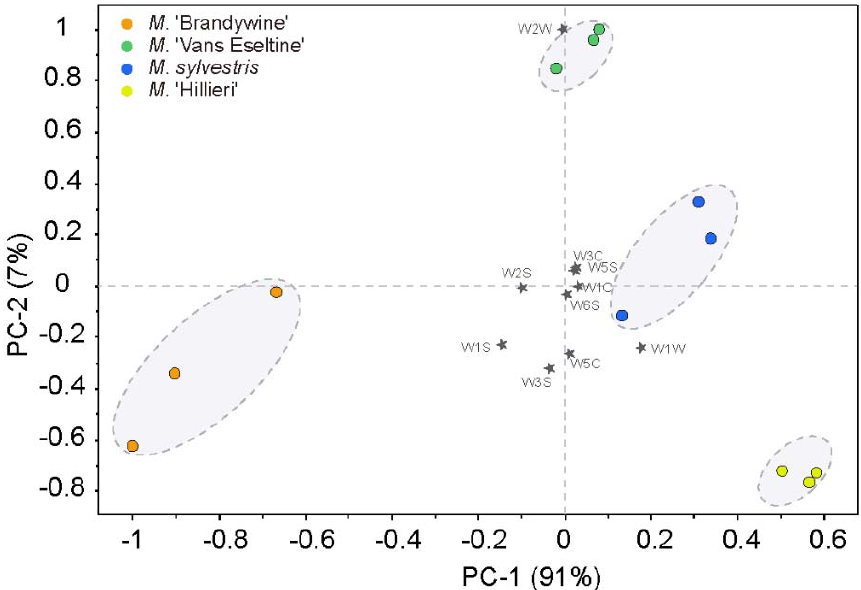
Figure 1. PCA biplot based on the E-nose data of the flowers of the four Malus taxa.